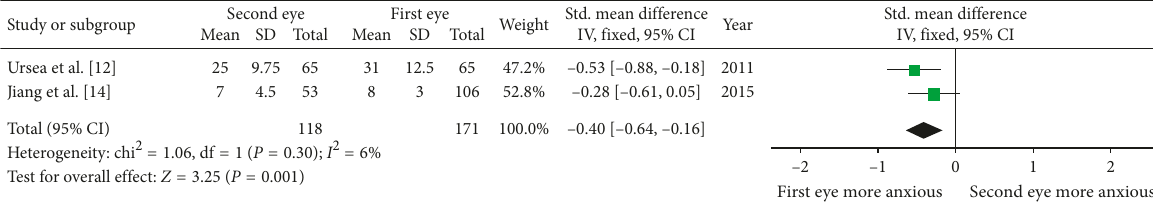
Figure 5: Forest plot comparing the anxiety scores.